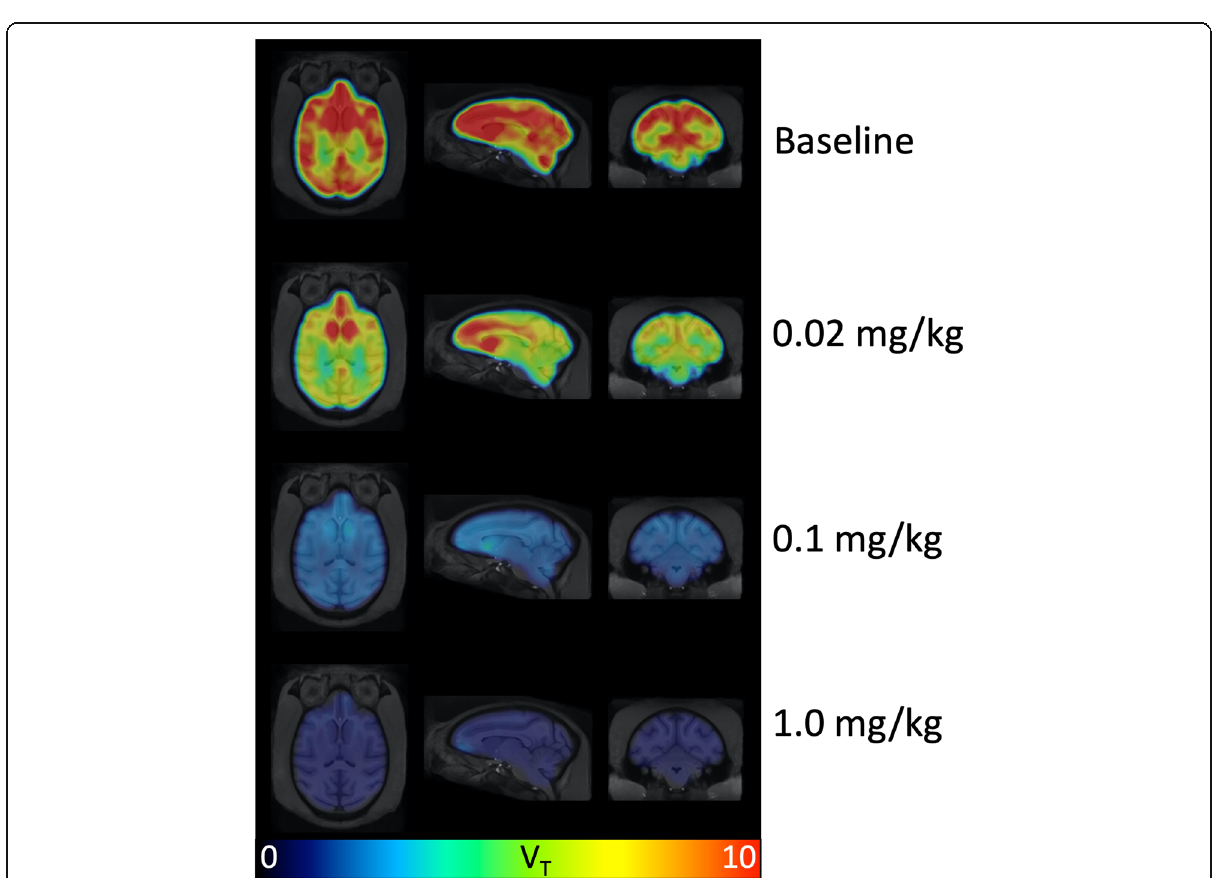
Fig. 4 V T parametric images from baseline and three blocking scans with AR-9281 in Baboon3. The Logan graphic method was used to generate the V T